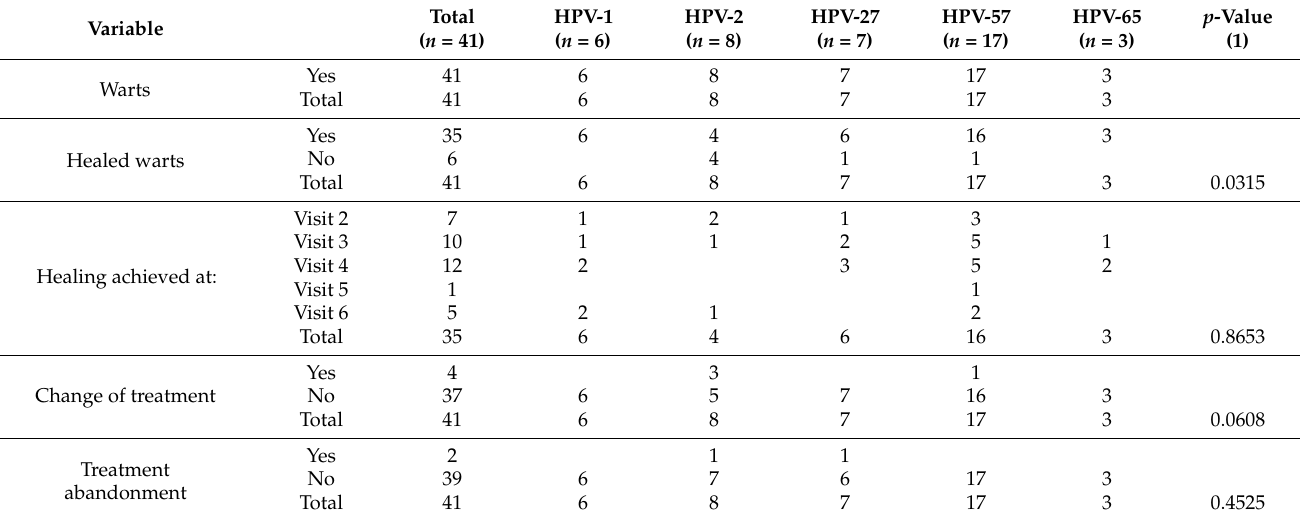
Table 1. Warts healed by laser treatment.